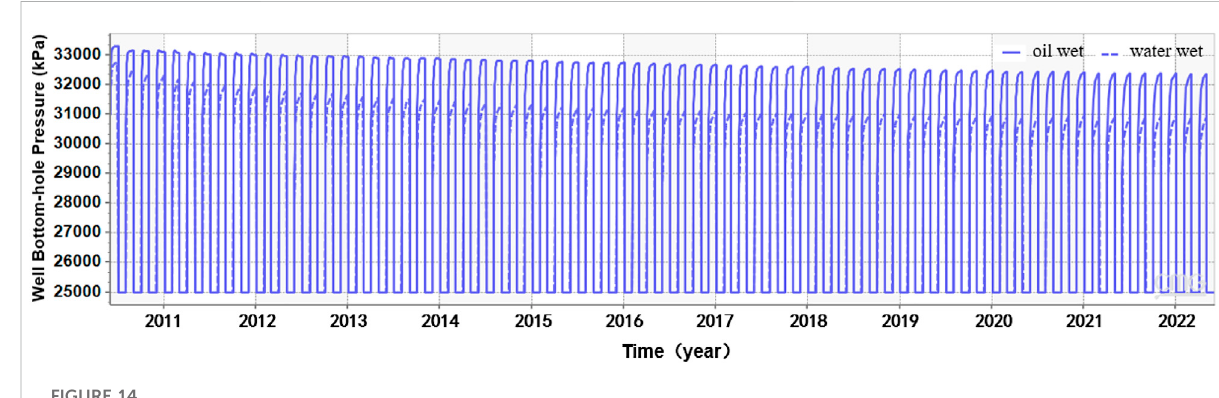
FIGURE 14 Bottom fl ow pressure in well W under different wettability